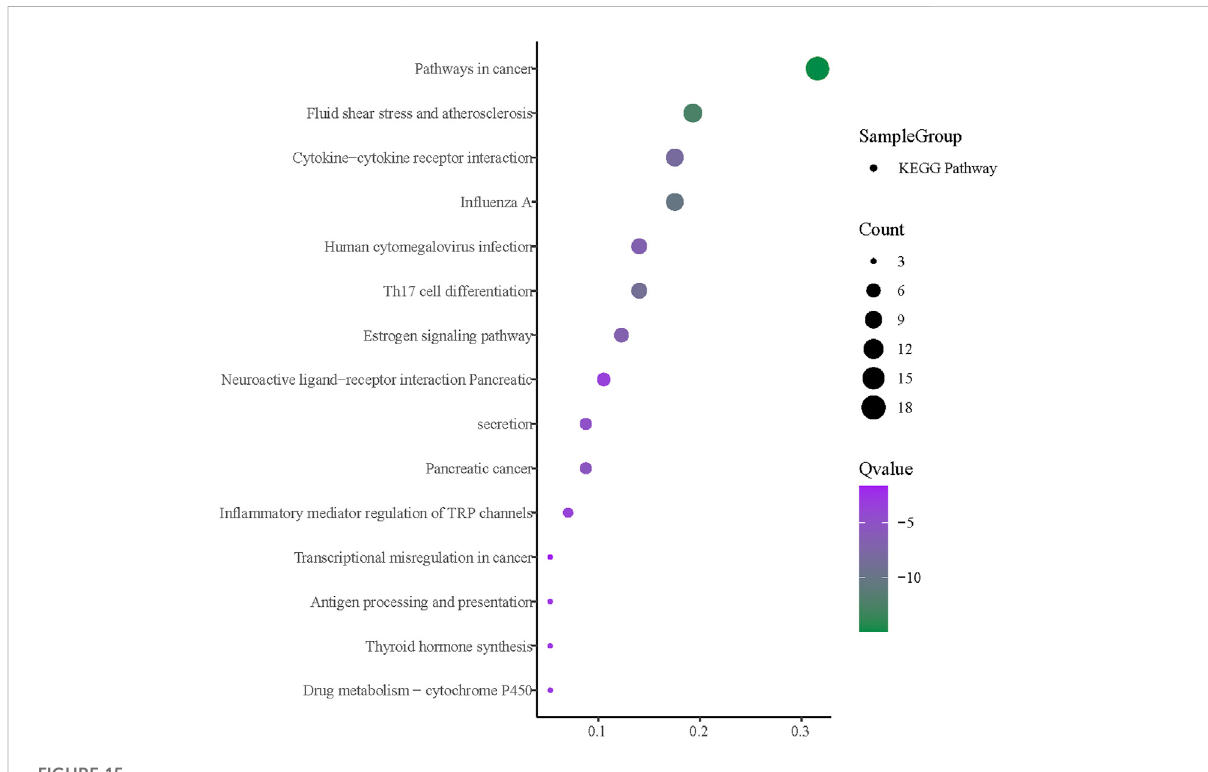
FIGURE 15 KEGG enrichment